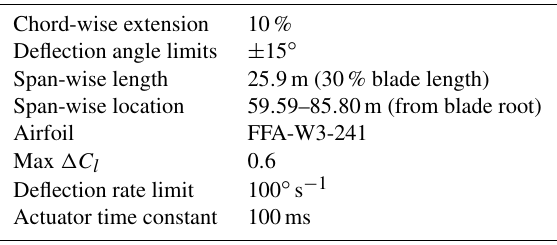
Table 2. Summary of flap